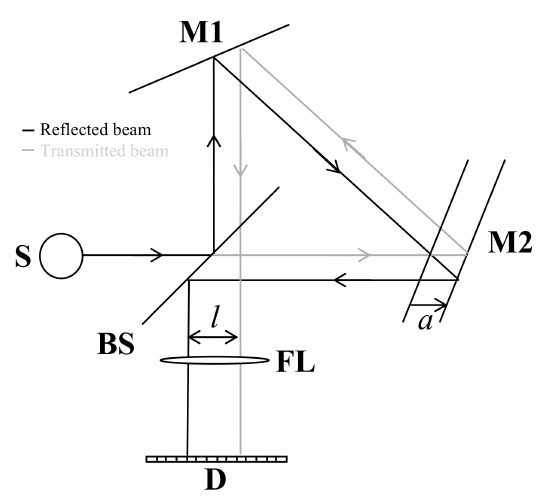
Figure 1. Scheme of the static modulated Fourier transform spectrometer based on a modified Sagnac interferometer. S is a source, M1 is a fixed mirror, BS is a beam splitter, FL is a focusing lens, D is a one-dimensional detector, and M2 is a displaced mirror. From the BS, black and grey solid lines indicate the reflected and the transmitted beams,